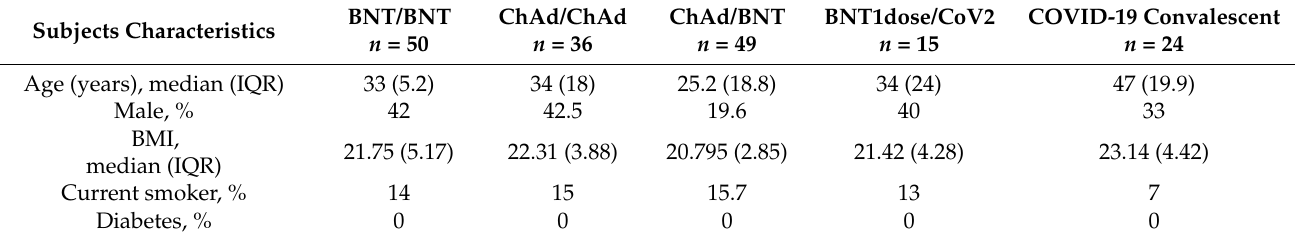
Table 1. Characteristics of enrolled